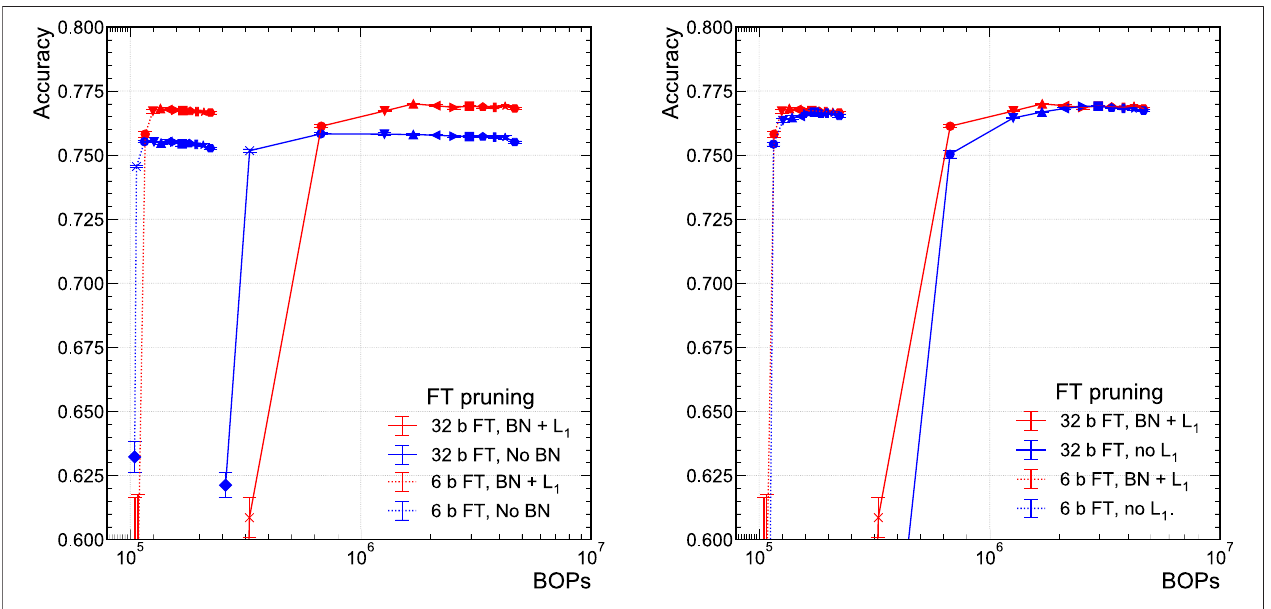
FIGURE5| ComparisonofthemodelaccuracywhentrainedwithBNlayersand L 1 regularizationversuswhentrainedwithoutBNlayers (A) or L 1 regularization (B) .